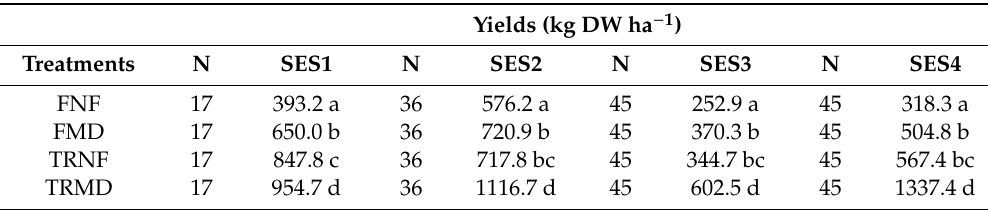
Mean yields followed with the same letter in the same column are not statistically significantly different (ANOVA p ≤ 0.05/Holm's sequential Bonferroni post-hoc test). N is the number of samples for each treatment; FNF denotes flat cultivation without microdosing; FMD denotes flat cultivation with microdosing; TRNF denotes tied ridge cultivation without microdosing; and TRMD denotes tied ridge cultivation with microdosing).